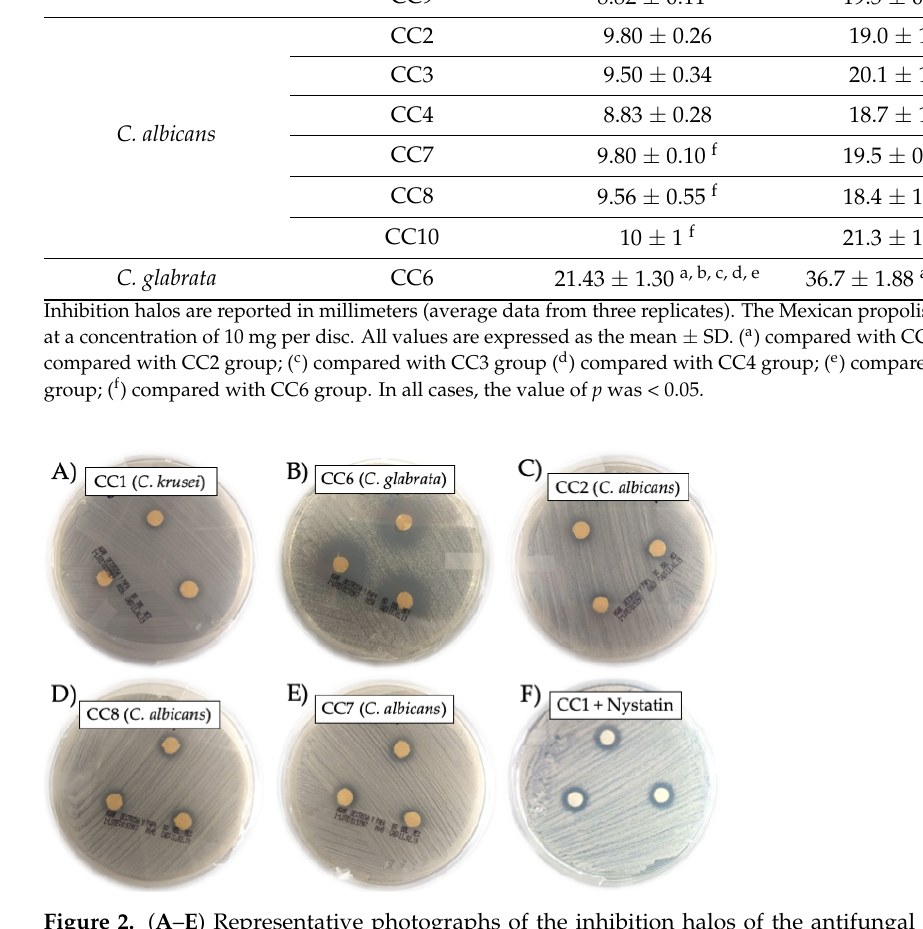
Table 1. Qualitative evaluation of the anti- Candida activity of Mexican propolis. Candida Strain Sample Propolis (mm)